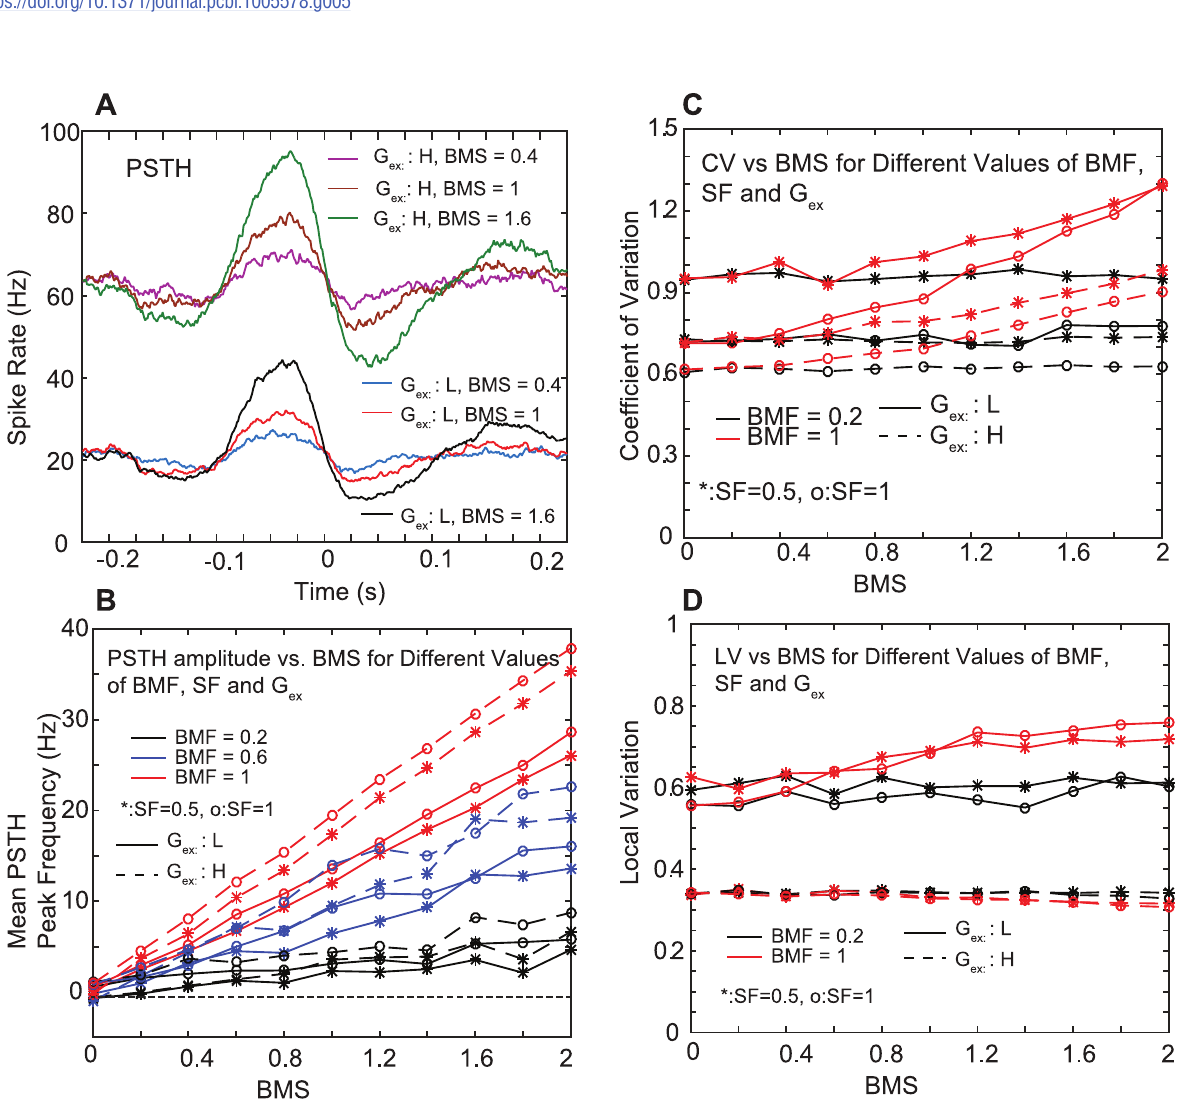
Fig 6. Model PSTH as a function of input AST properties. A. The averagerespiratory modulation in the spike output smoothlyvaries with the amplitudeof respiratorymodulationin the inputs (behavioralmodulation strength (BMS): gain factor between0 and 2 appliedto the respiratory rate modulation of the sample recordingfrom which ASTs were generated (Fig 5A and 5B)). The G in was 16 nS, and the model was tested for 2 spike rates achievedwith a high level of 6 nS and a low level of 3.5 nS for G ex . B. The amplitudeof respiratory spike train modulation was scored as the mean frequencyincrease duringthe peak. The output spike frequency increaseis nearly linear with increasing BMS of the inputs. The slope of this line is a function of the fraction of modulated inputs (BMF). The SF in the background rate covariance has little effect on the PSTH, but the frequency increasesare higherwhen the baselinespike rate is 60 Hz than when it is 20 Hz. C,D. The CV and LV as a function of BMS for two values of BMF and 2 levels of excitationG ex : H(igh) resultingin a 60 Hz baseline, and G ex : L(ow) resulting in a 20 Hz baseline(see A). The CV is moderately affected by increasingBMS when the baseline spike rate is low.